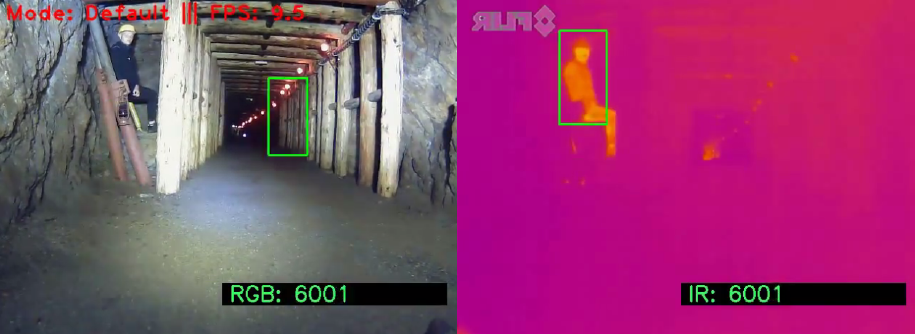
Figure 24. Human obscured—wrong detection in RGB image with HOG